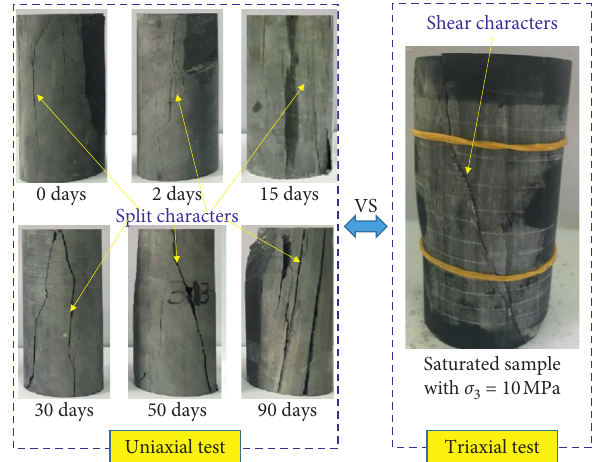
Figure 12: Failure morphology of shale samples in the uniaxial test and triaxial